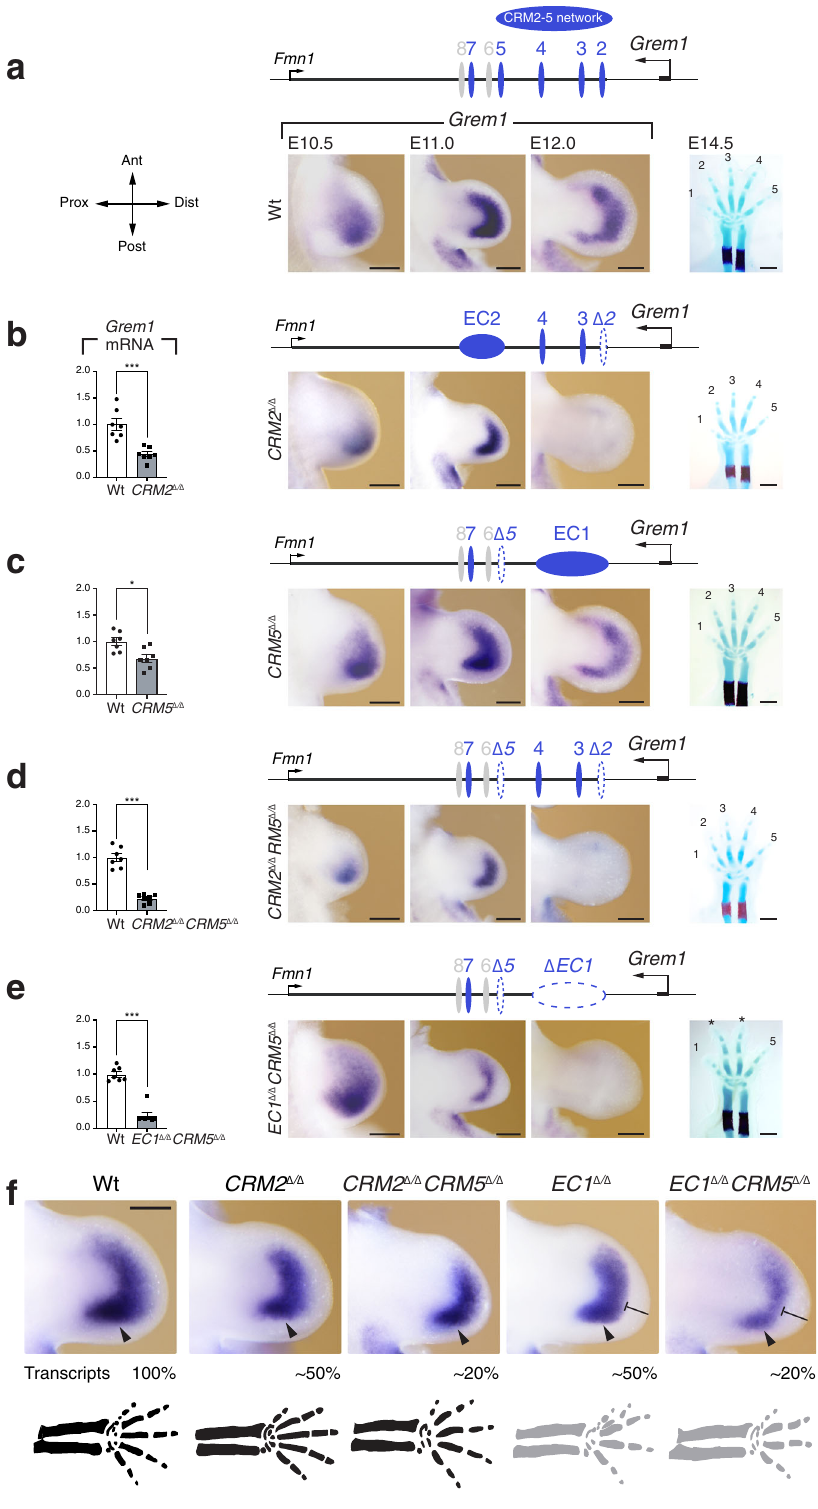
In EC1 Δ / Δ and EC2 Δ / Δ forelimb buds Grem1 expression is acti- vated normally, while no activation is detected in EC1 Δ / Δ EC2 Δ / Δ forelimb buds (Supplementary Fig. 4). In EC2 Δ / Δ forelimb buds, the dynamic Grem1 expression pattern is similar to wild-type limb buds, i.e. expands distal-anterior into a crescent-shaped domain that retains its posterior bias (E10.5, E11.0, Fig. 2b, d; Supplementary Fig. 4) 22 . In contrast, this posterior bias is reduced